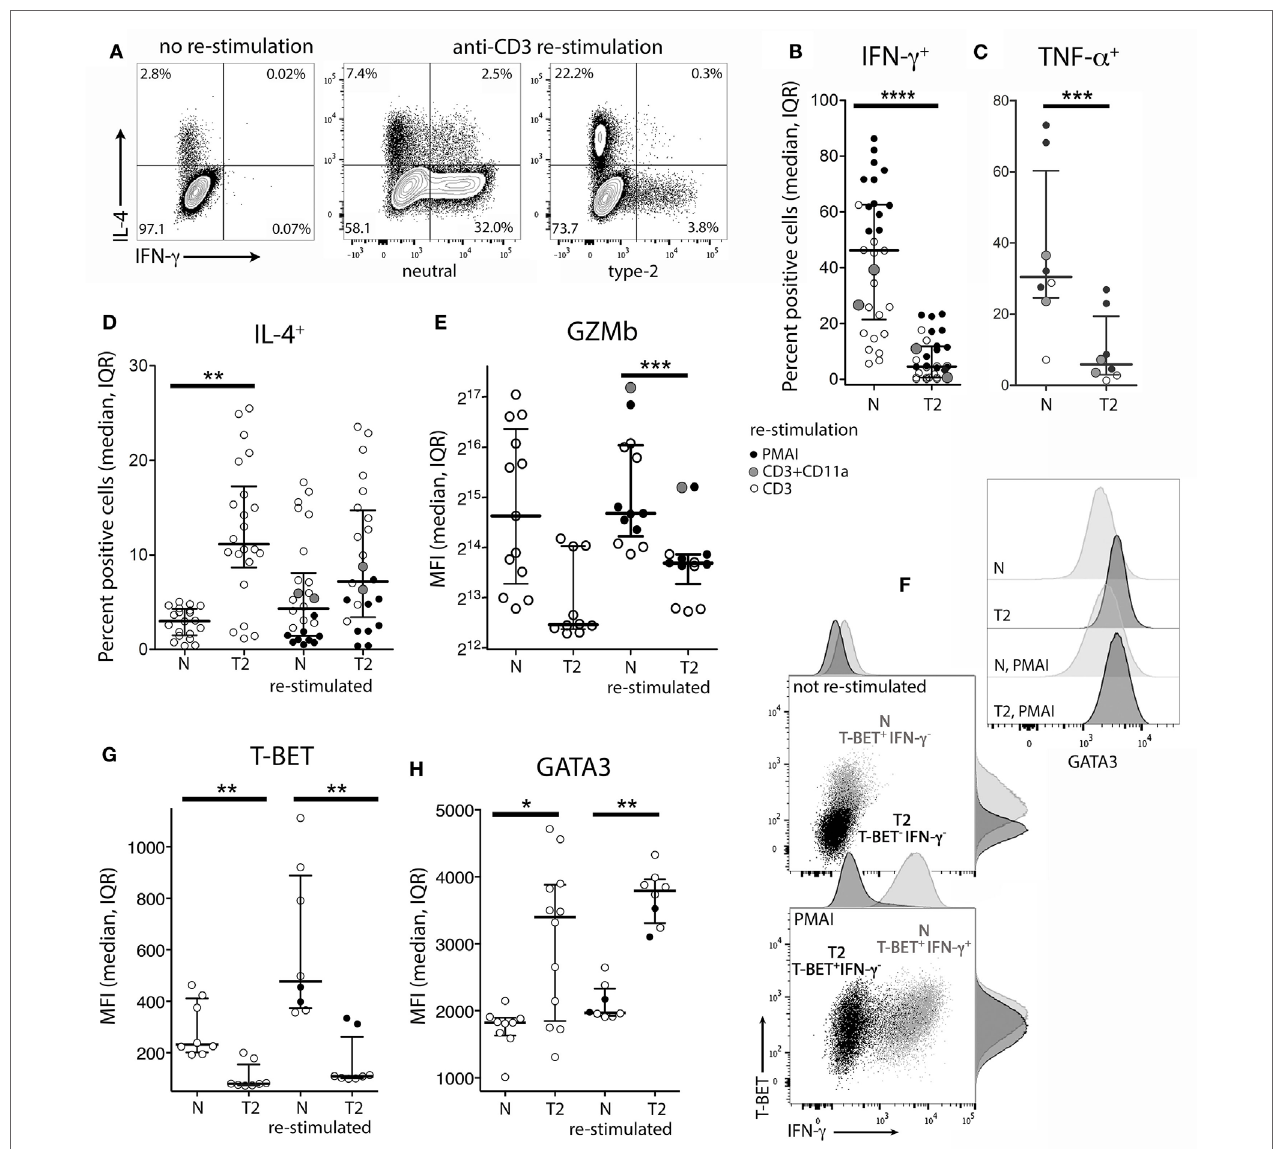
FigUre 2 | Intracellular cytokine and transcription factor production by CD8 + T N stimulated in neutral or type-2 (T2) conditions. CD8 + T N were activated in neutral (N) or T2 conditions for 5 days, rested for 3 days, then cultured for a further 5 h with or without restimulation before intracellular or nuclear staining and flow cytometry. (a) Representative plots for IFN- γ versus IL-4 staining. (b–e,g,h) Each dot represents a sample from up to 13 donors, some of whom were assessed in up to three different experiments. Data are presented as median and interquartile range (IQR). IFN- γ and TNF- α were not detected in non-restimulated cultures (data not shown). p -Values for pairwise comparisons of neutral versus T2-primed cells are indicated (**** p < 0.0001, *** p < 0.001, ** p < 0.01, and * p < 0.05). (F) Plots for one of two donors whose cells were costained for IFN- γ , T-BET, and